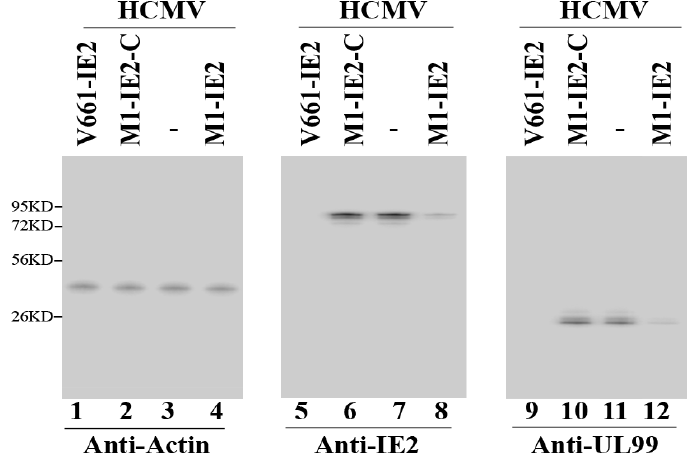
Figure 4. Levels of HCMV proteins observed by Western Blot. Actin control (lanes 1–4), IE2 (lanes 5–8), and UL99 (lanes 9–12). Cells ( n = 1 × 10 6 ) were infected with HCMV (MOI = 1) and were harvested at either 24 (lanes 1–8) or 72 h (lanes 9–12) post-infection.